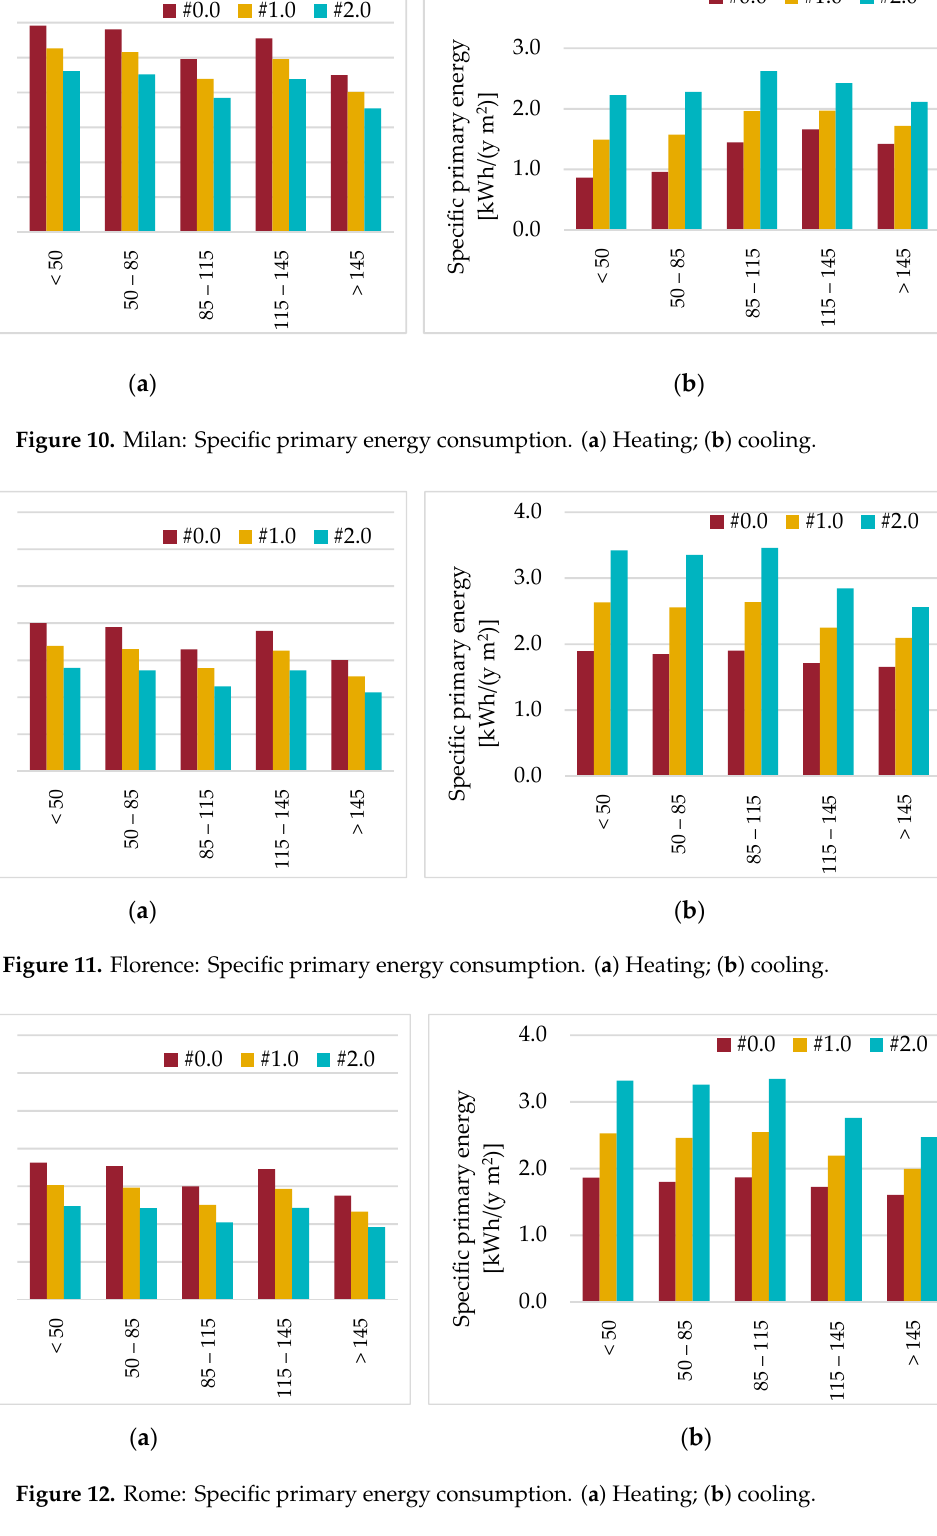
( b ) Figure 13. Naples: Specific primary energy consumption. ( a ) Heating; ( b ) cooling. As it was expected, the simulation results show a reduction in heating consumption and an increase in cooling consumption. Basically, it is possible to state that heating consumption tends to decrease, while cooling consumption grows up, and they are not strongly influenced by floor surface. Indeed, the percentage reductions in the cold season are strictly related to the location and are smaller where the degree days are greater. More generally, the percentage reductions are very similar for all case studies except for Naples, where they are higher. 3.4. Change in Cooling Energy Consumption with the Addition of Air Conditioners This section illustrates the simulations results to identify the enhancement of cooling energy need, when outdoor environmental conditions change. Six different scenarios have been built once average temperature increases equal to 1 and 2 °C are implemented along with an additional air conditioner (scenarios #0.1, #1.1, #2.1) or two air conditioners (scenarios #0.2, #1.2, #2.2); the variations in cooling consumption, with the existing equipment, (scenarios #0.0, #1.0, #2.0), have been already